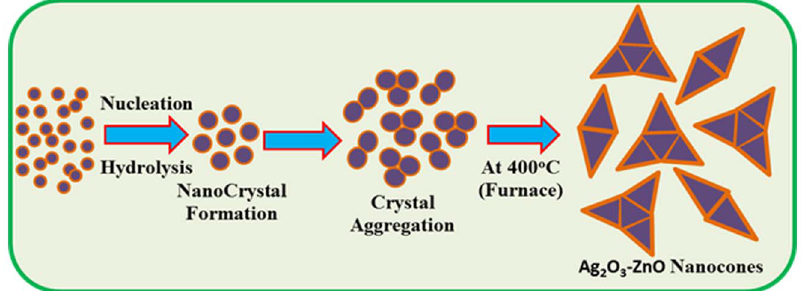
Figure 1. Crystal growth mechanism. Schematic representation of growth mechanism of doped Ag 2 O 3 -ZnO NCs prepared by wet-chemical